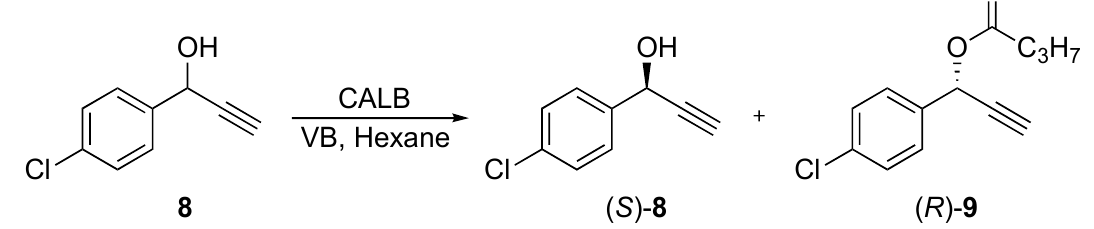
Scheme 3. Kinetic resolution of 9 with CALB as the catalyst and vinyl butanoate in dry hexane.